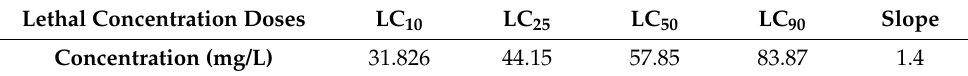
Table 1. Myco-synthesized SeNPs’ molluscicidal activity against B. alexandrina snails after 96 h of exposure.